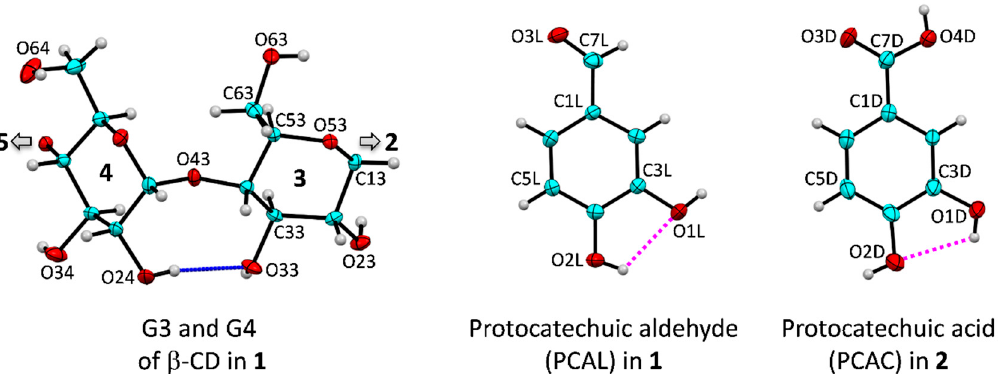
Figure 1. Atom numbering of β -CD, PCAL and PCAC molecules; ORTEP plot at 30% probability level. The intramolecular, interglucose O3( n )···O2( n + 1) hydrogen bonds stabilizing the annular conformation of β -CD macrocycle are shown for glucose units G3 and G4 (blue connecting line); for a complete molecule, see Figure 4. PCAL and PCAC are stabilized by intramolecular O2L–H···O1L and O1D–H···O2D hydrogen bonds, respectively (magenta dotted lines).